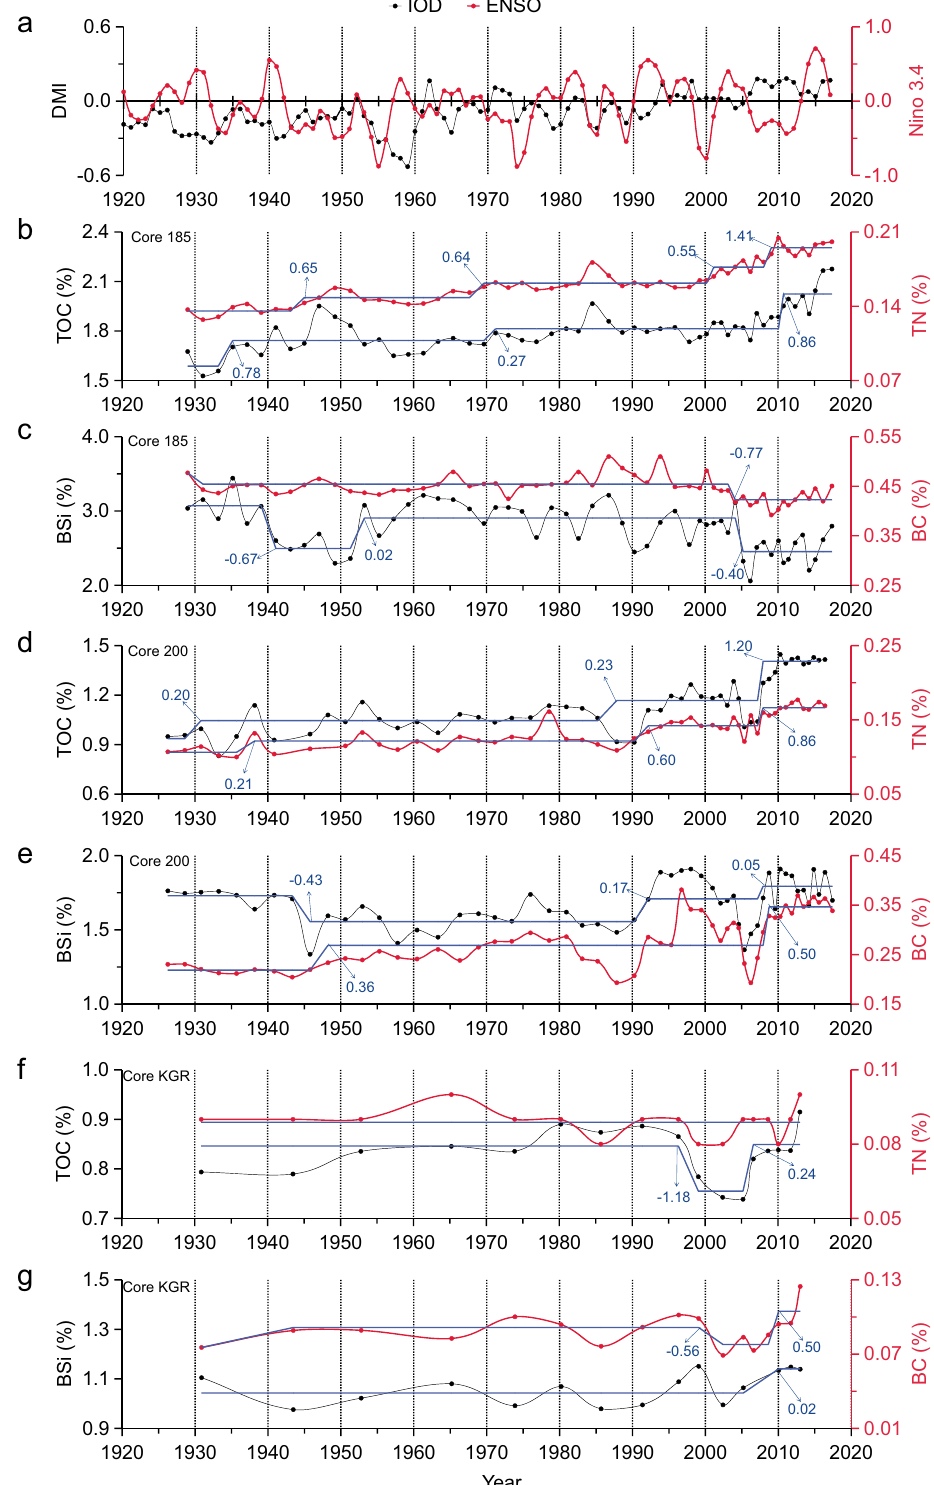
Fig. 2 The pro fi les to illustrate the variations of El Niño Southern Oscillation (ENSO), the Indian Ocean Dipole (IOD), and multiple geochemical proxies in the three sediment cores from the 1920s to 2010s. a Low-frequency signals of dipole mode index (DMI) and Niño 3.4 index showing the variations of IOD and ENSO, respectively. b Core 185: total organic carbon (TOC) and total nitrogen (TN). c Core 185: biogenic silicate (BSi) and black carbon (BC). d Core 200: TOC and TN. e Core 200: BSi and BC. f Core KGR: TOC and TN. g Core KGR: BSi and BC. Blue lines represent the shift changes assessed by sequential t test analysis of regime shift and numbers on lines were regime shift index (RSI) to show shifting